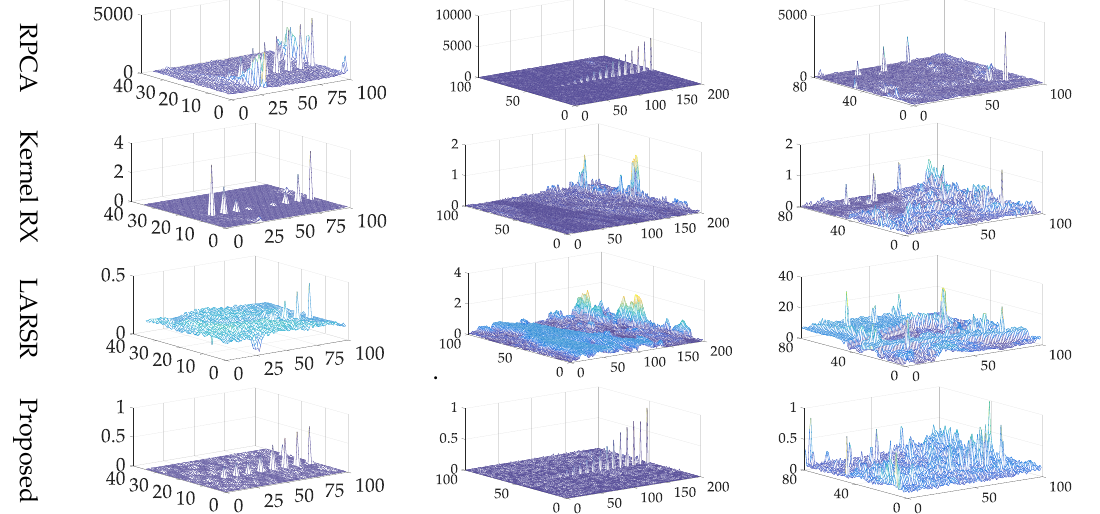
Figure 10. Experimental data on each dataset (Patch 7 in Dataset-1, Patch 3 in Dataset-2).